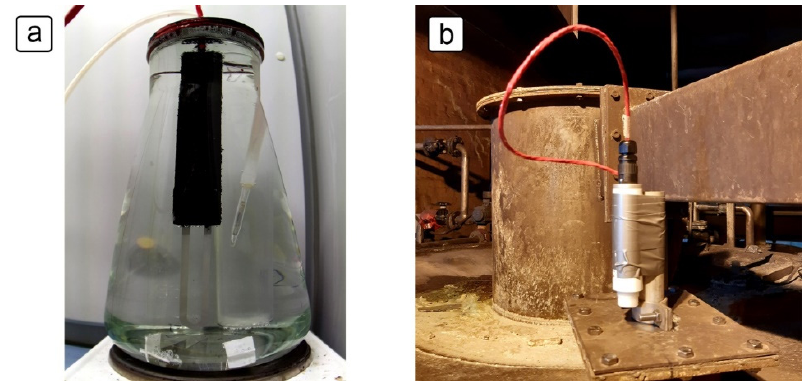
Figure 3. ER sensor exposure setup: ( a ) in the laboratory; ( b ) under industrial